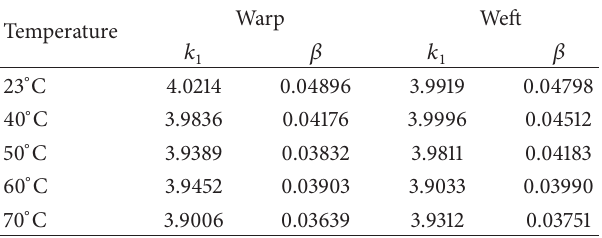
Table 4: Parameter results of the fractional Maxwell